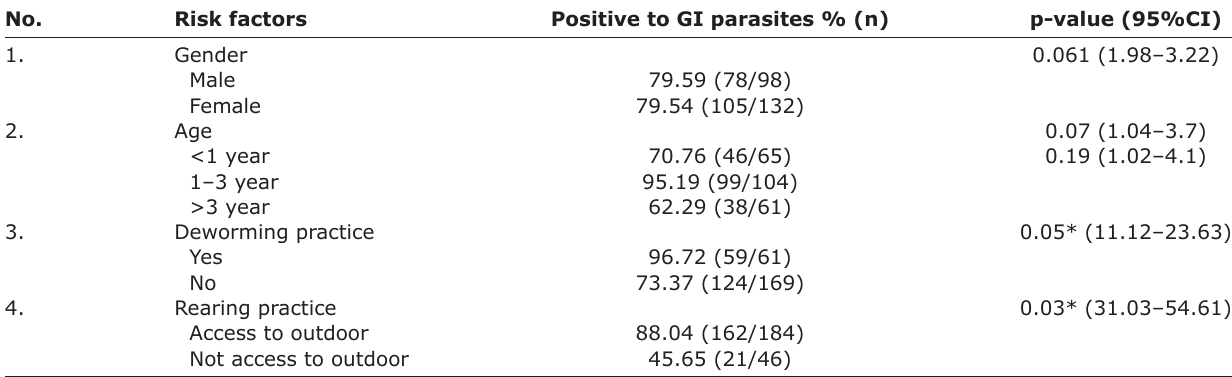
Table-5: Analysis of risk factors associated with GI parasite infection amongst domestic owned and sheltered cats from Yangon, Myanmar. No. Risk